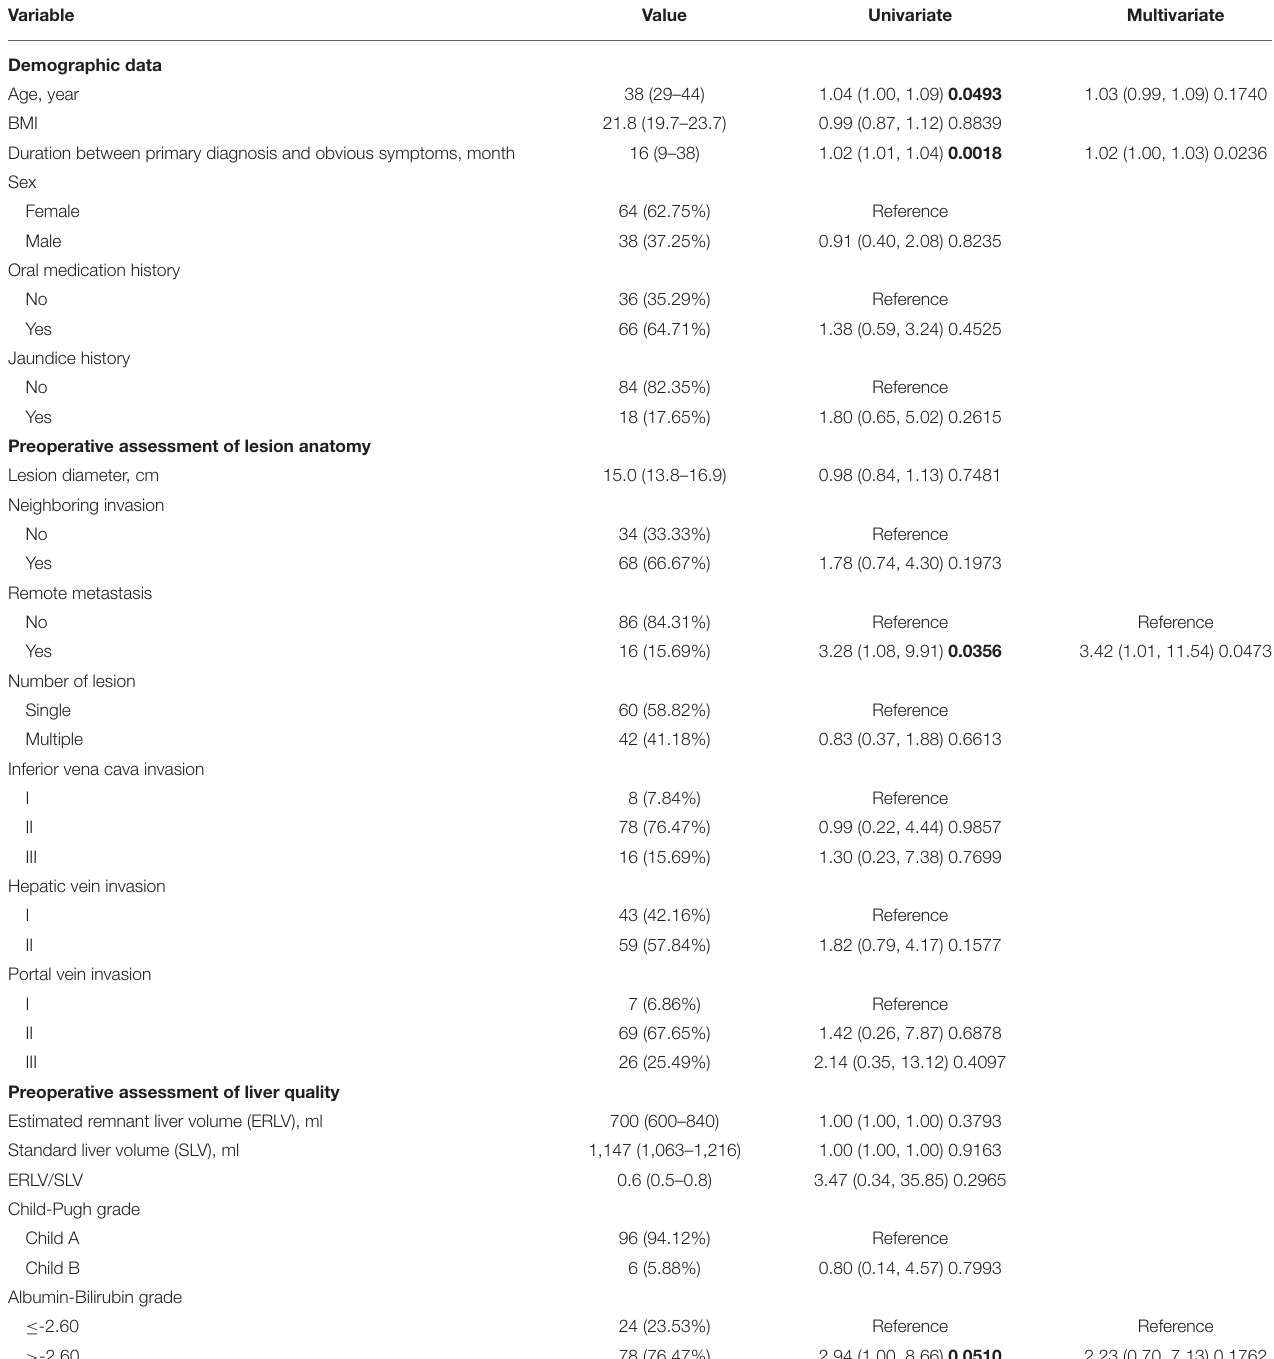
TABLE 1 | Univariate and multivariate logistic regression analyses of risk factors predicting major